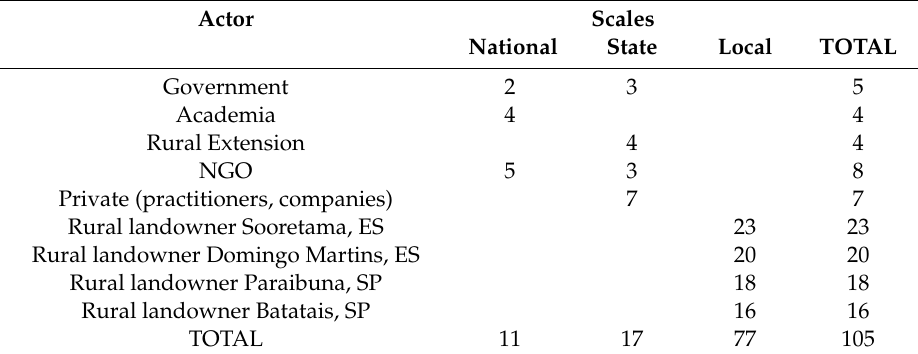
Table 5. Breakdown by actor and scales of the interviews conducted. Actor Scales National State Local TOTAL Government 2 3 5 Academia 4 4 Rural Extension 4